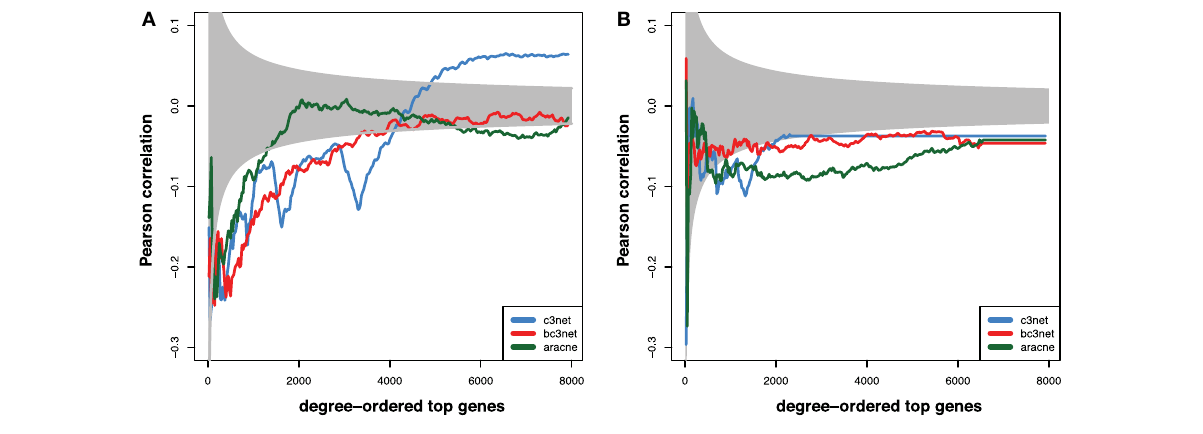
their degree centrality values in the GRNs compared to: (A) PPN and (B) TRN. The ordering is from high to low degree